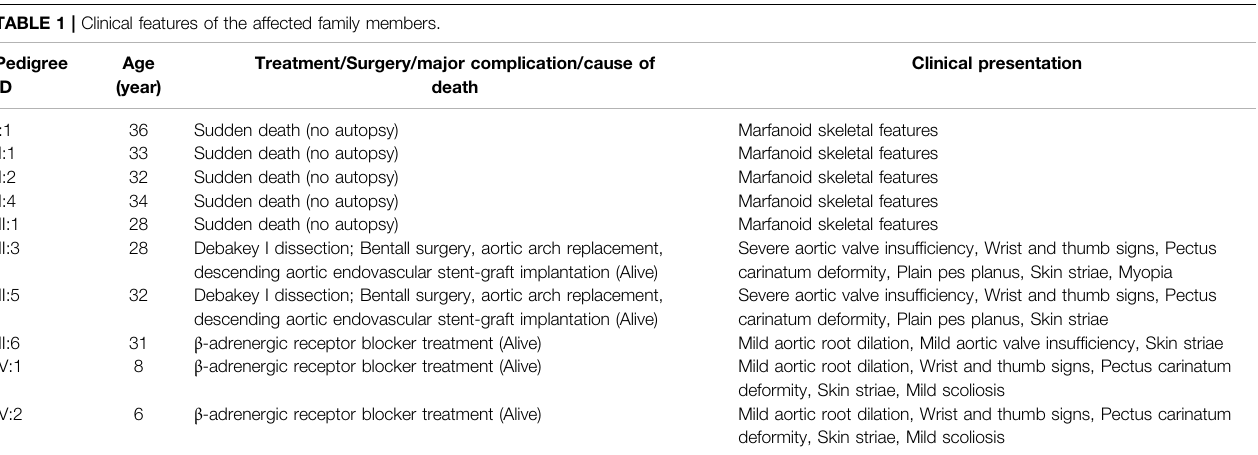
TABLE 1 | Clinical features of the affected family